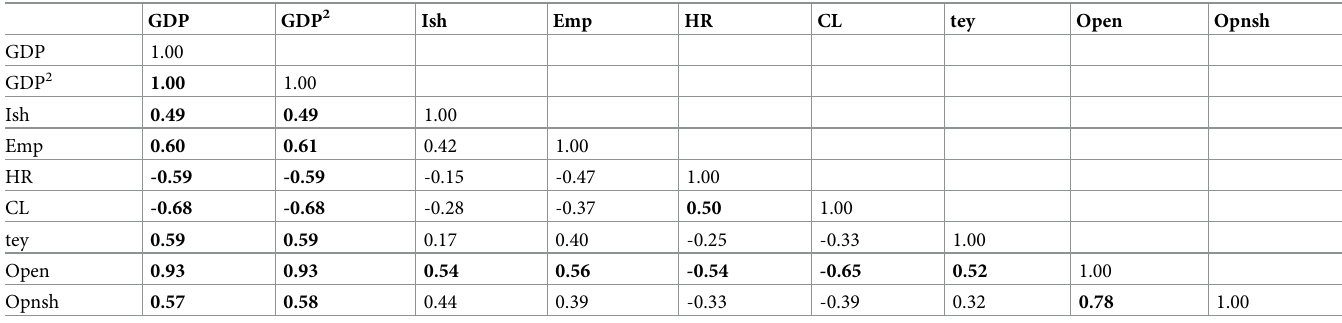
Table 2. Bilateral correlations among selected variables in the original